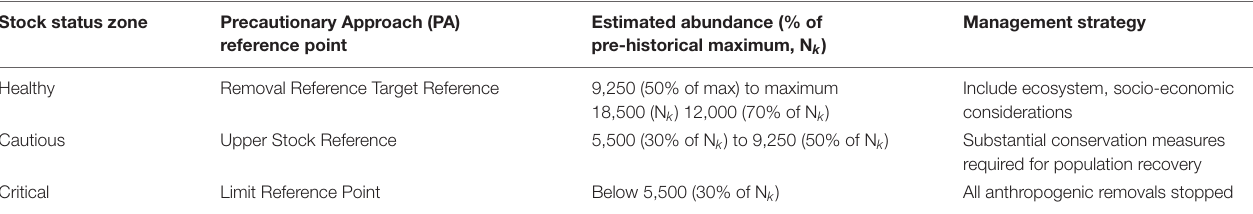
TABLE 3 | Stock status zones and reference points proposed for a Precautionary Approach to co-management of the Eastern Canada-West Greenland bowhead whale population, based on historical (pre-commercial exploitation) population abundance (Higdon and Ferguson, 2016). Stock status